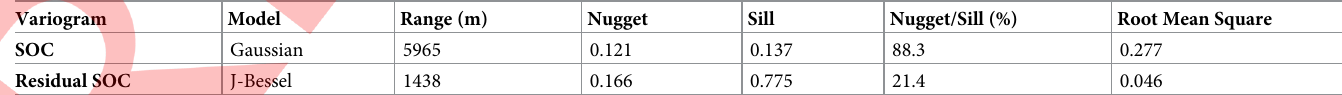
Table 3. Semivariogram model parameters for soil organic carbon (SOC) content and residual ordinary kriging interpolation in training areas. Variogram